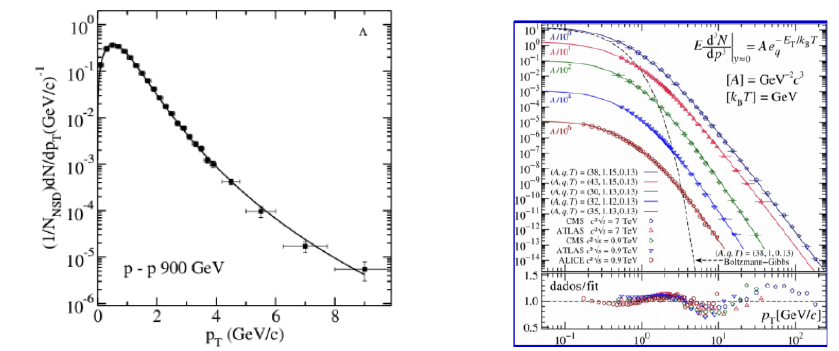
Figure 5. Left panel: An example of fit of the calculated distribution to experimental data. Right panel: Fitting of the p ⊥ distribution formula to experimental data. Notice that the formula can fit well data over 15 orders of